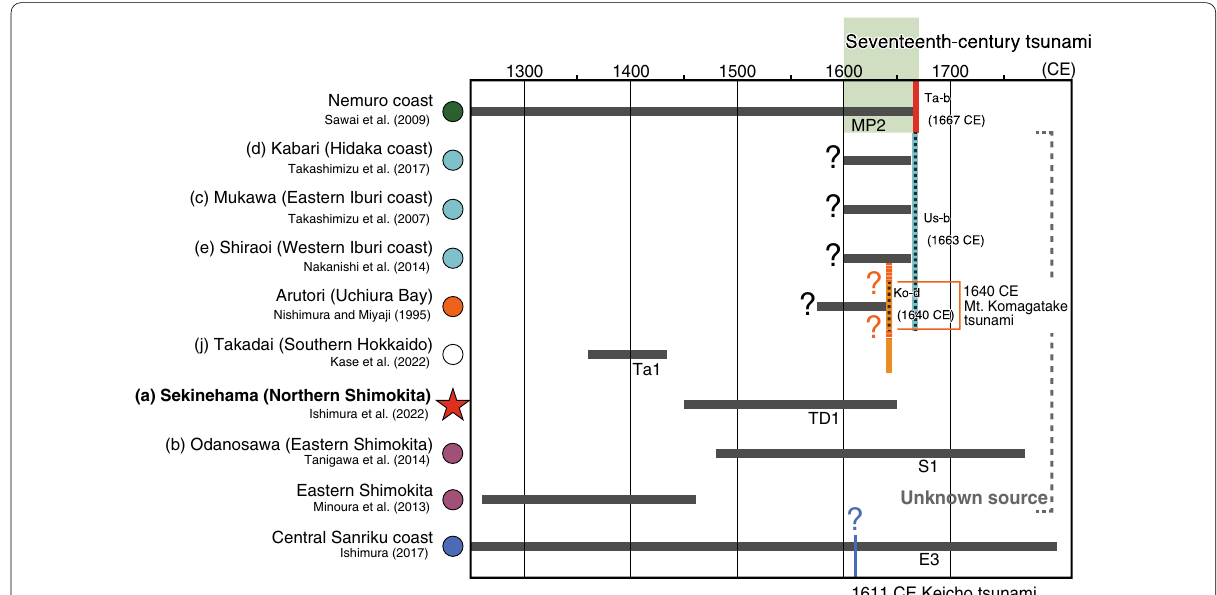
Fig. 2 Radiocarbon age list of historical tsunami deposits in the thirteenth–eighteenth century used in this study. The vertical and horizontal axes show the main locations of the tsunami deposits and their ages, respectively. Each color corresponds to the colors in Fig. 1. The dark-gray horizontal bars indicate a 2σ range of the radiocarbon age of each event deposit. The colored vertical bar indicates the historical key volcanic